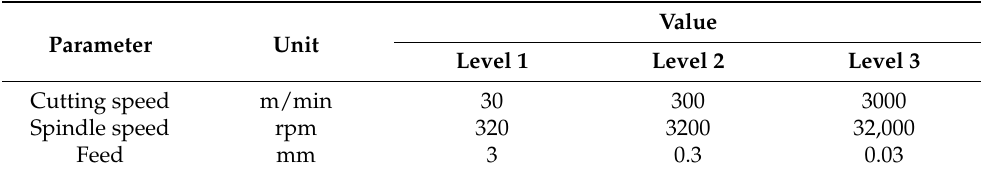
Table 2. Variable cutting parameters of the